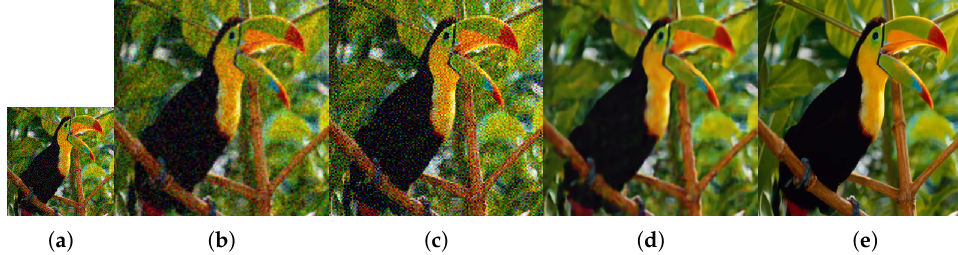
Figure 1. Generated images and PSNR results obtained from bicubic upsampling, DIP-SR [1], and our method when the input LR image is noisy (scaling factor = 2). Note that our method does not suffer from noise, unlike bicubic upsampling and DIP-SR. ( a ) Input (21.05 dB), ( b ) Bicubic (23.66 dB), ( c ) DIP-SR [1] (18.43 dB), ( d ) Ours (26.67 dB) and ( e ) Ground